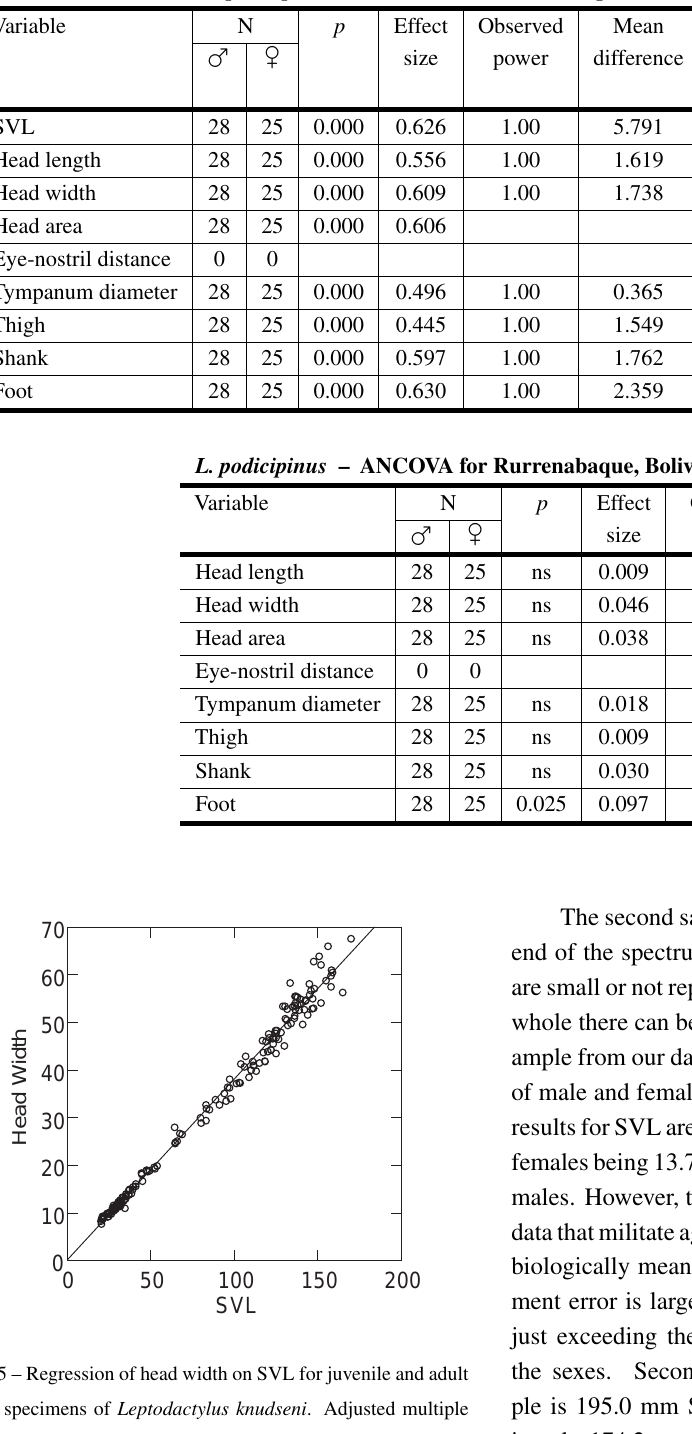
An Acad Bras Cienc (2005) 77